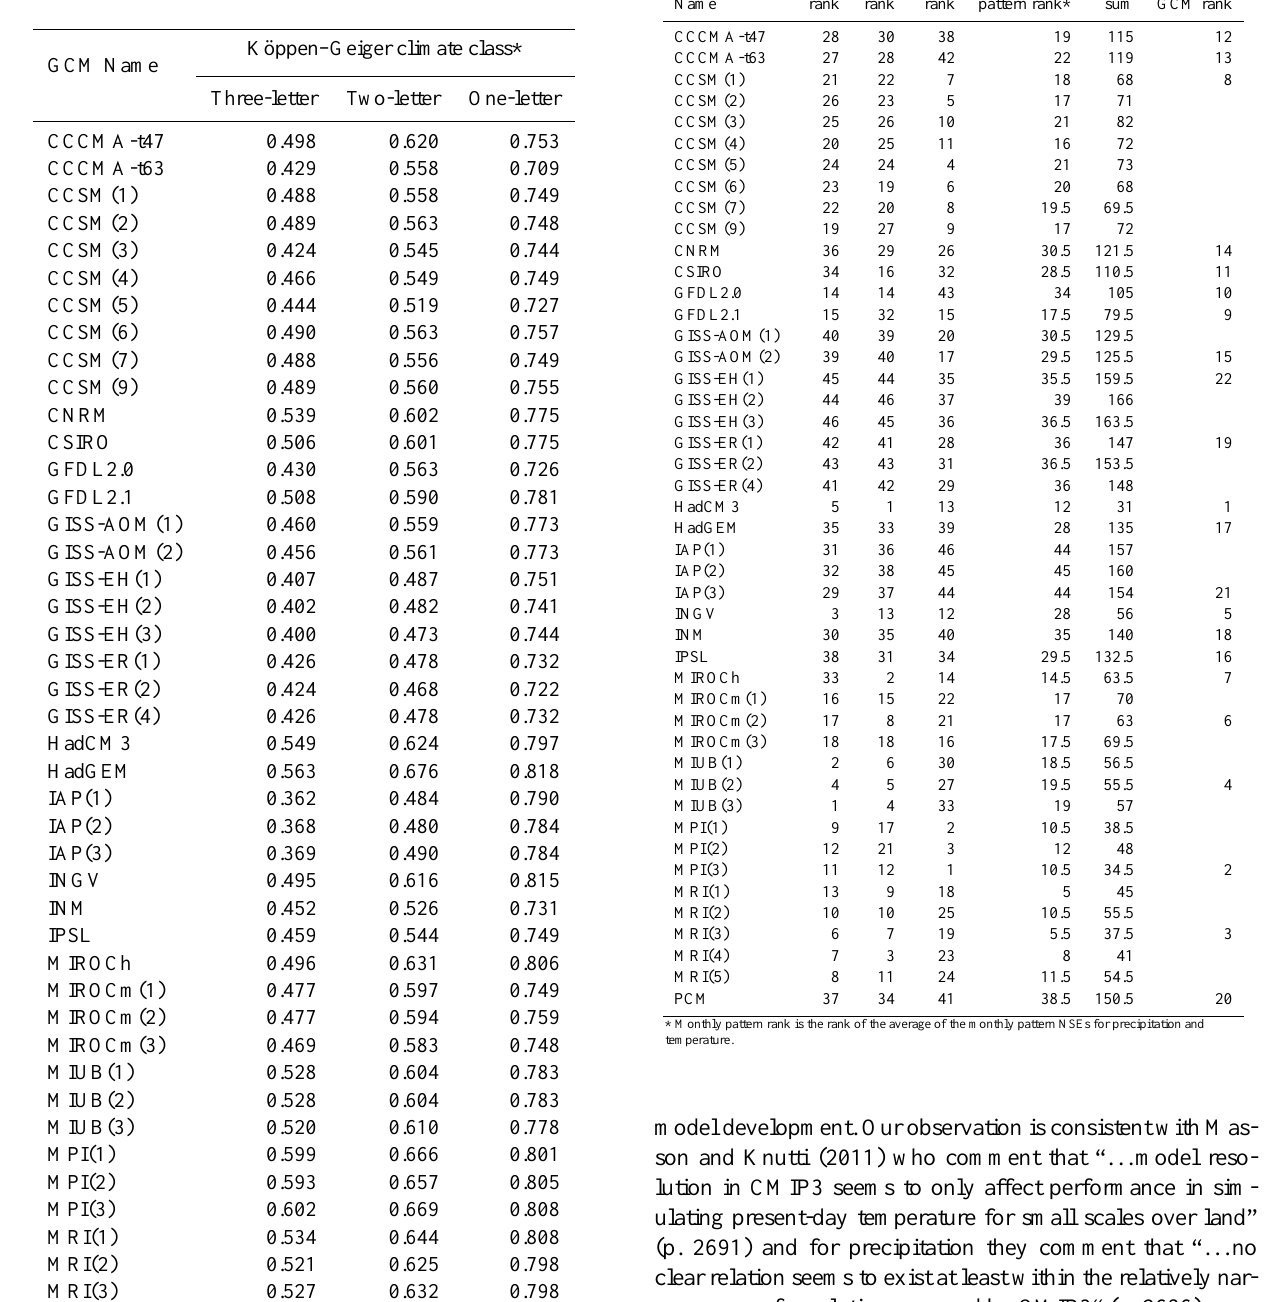
Table 7. Proportion of CMIP3 GCM grid cells (20C3M) that repro- duce observed CRU Köppen–Geiger climate classification over the period January 1950–December 1999.